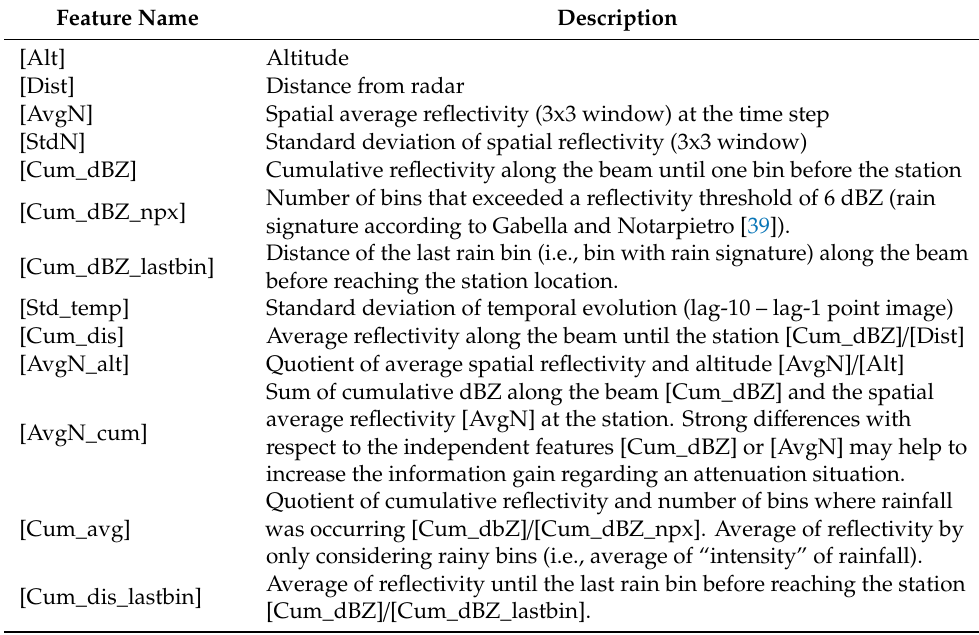
Table 3. Features used in the random forest model for radar rainfall